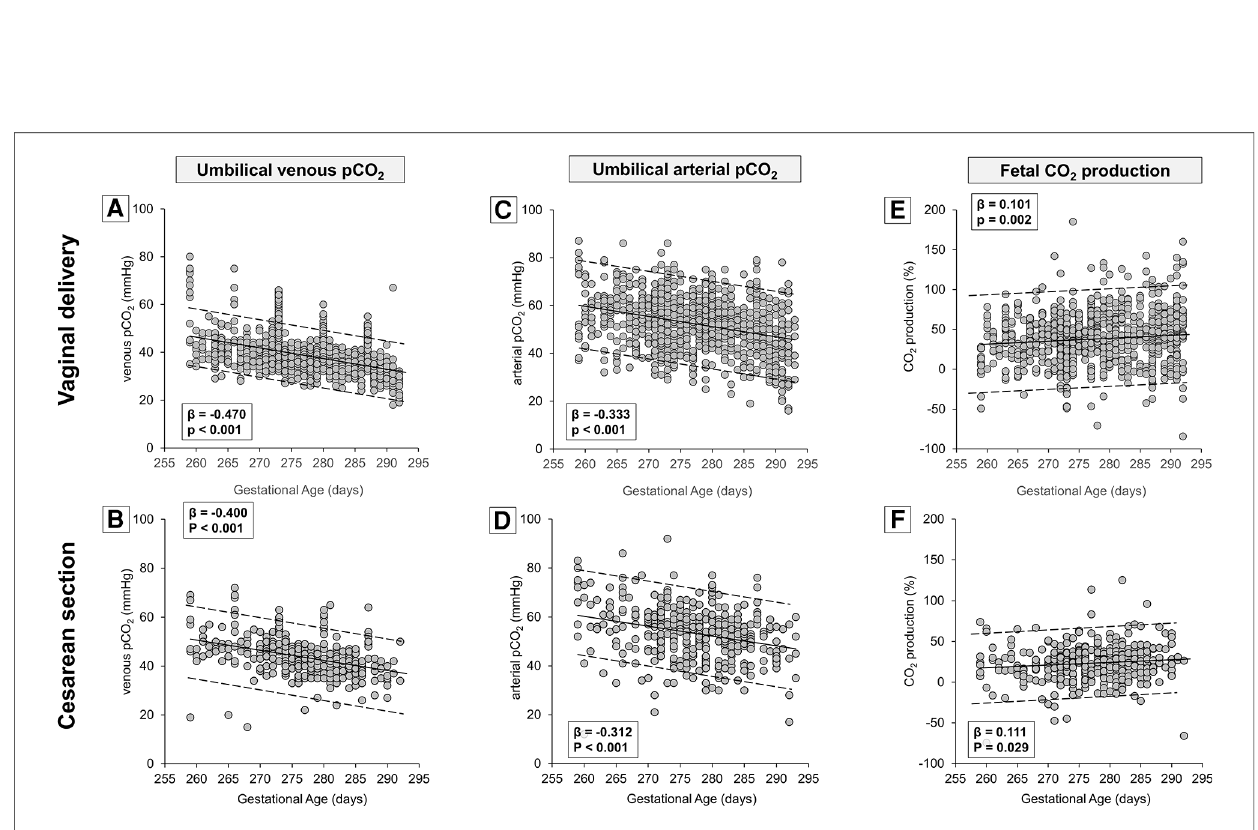
FIGURE 4 Scatter plots with regression lines and 95% prediction intervals representing umbilical-cord lactate levels [venous lactate, panel A ( n =893) — panel B ( n =284); arterial lactate, panel C ( n =909) — panel D ( n =283); fetal lactate production, panel E ( n =889) — panel F ( n =278)] strati fi ed by modality of delivery.